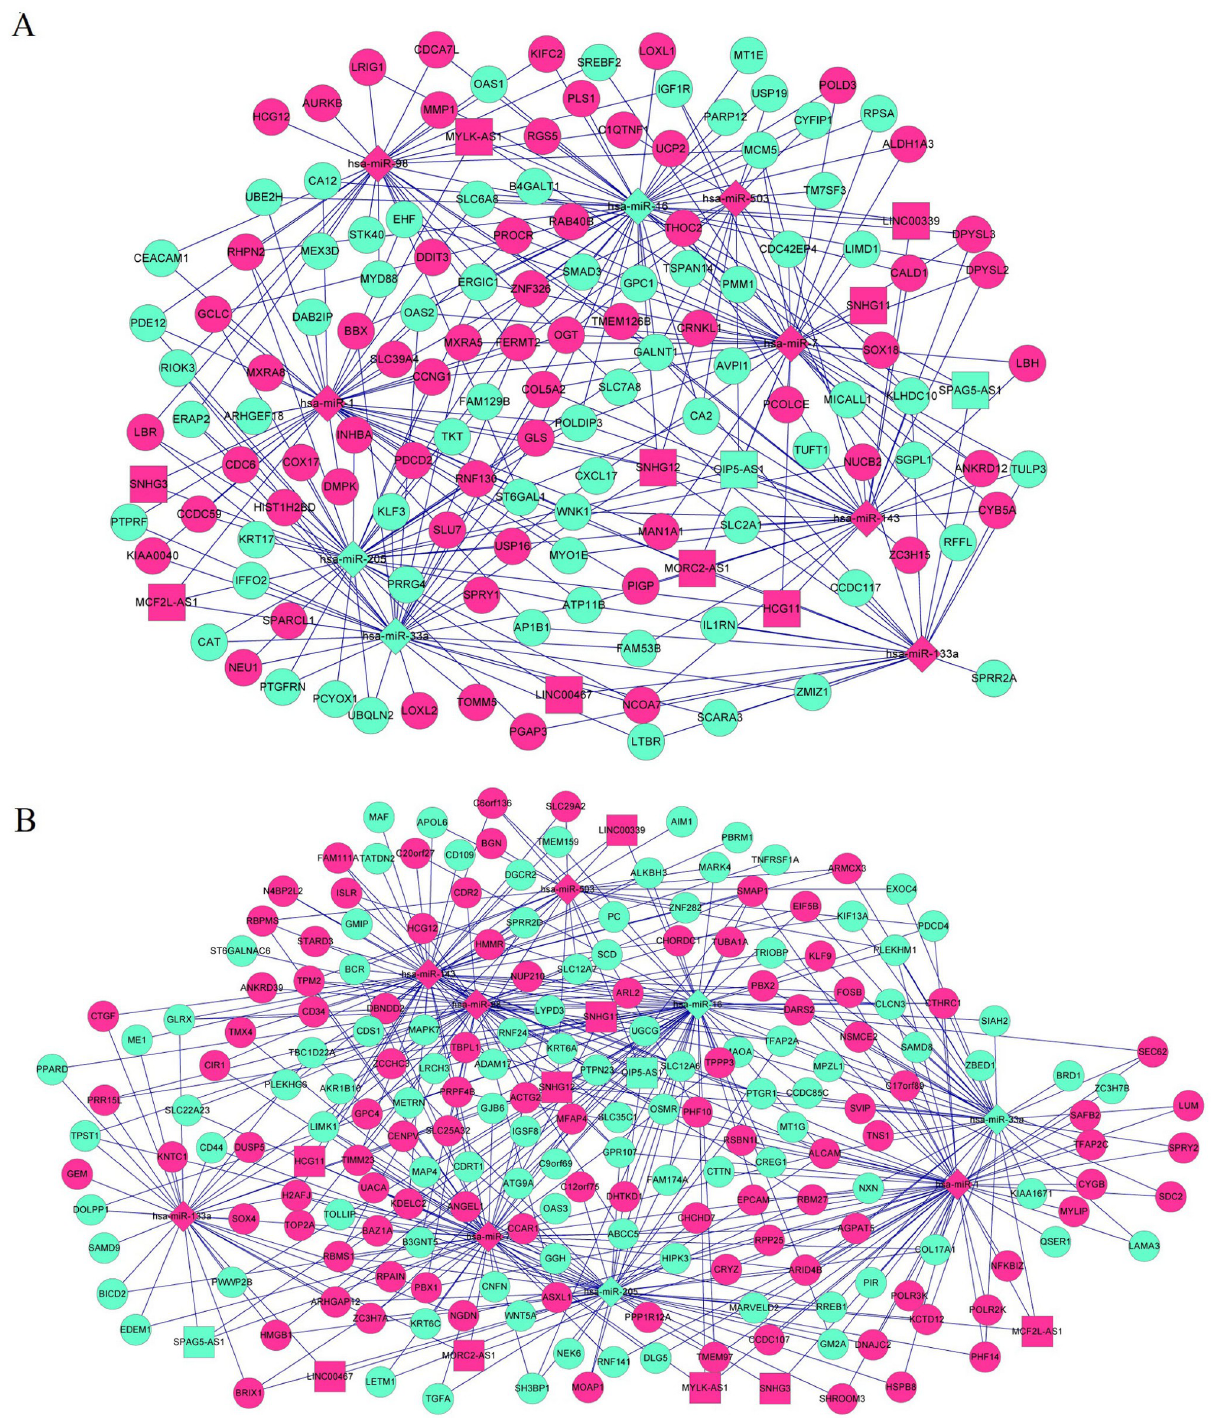
Fig 7. CeRNA regulatory network in alcohol-related EC progression. The lncRNA–miRNA interactions, and miRNA-target gene interactions were integrated as lncRNA-miRNA-target genes interactions, and ceRNA network was visualized based on lncRNA-miRNA-target genes interactions. A. The ceRNA network constructed by the DEGs in the blue module. B. The ceRNA network constructed by the DEGs in the turquoise module. Diamond, square, and round nodes represent miRNAs, lncRNAs, and mRNA, respectively. Red and green colors represent upregulation and downregulation,